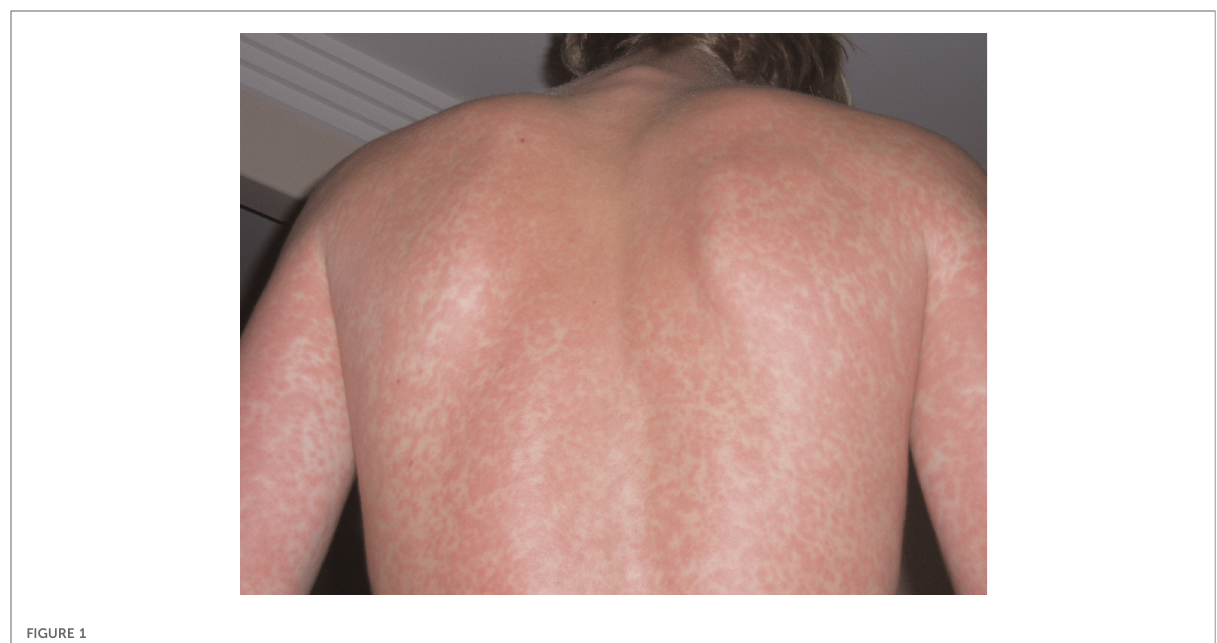
FIGURE 1 Maculopapular